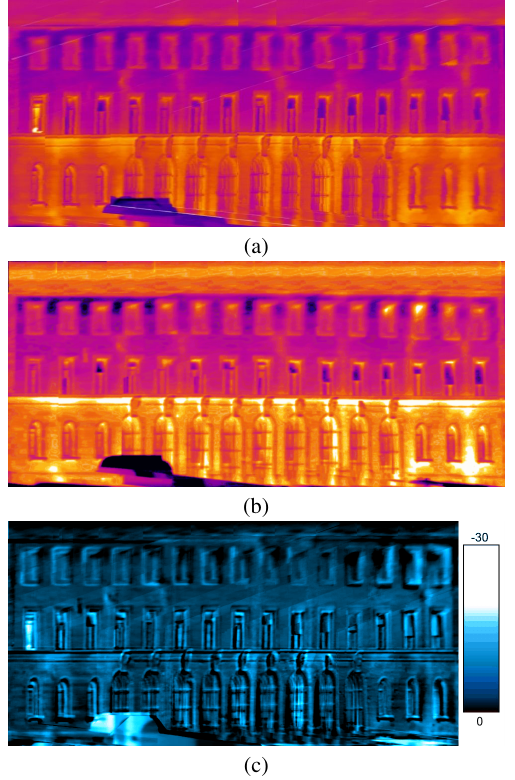
Figure 9. Cooling process in a difference texture from texture from a) evening and b) morning. c) Difference texture showing the cooling over night. Color scale in degree Celsius. Highest cooling at the open window and the car.